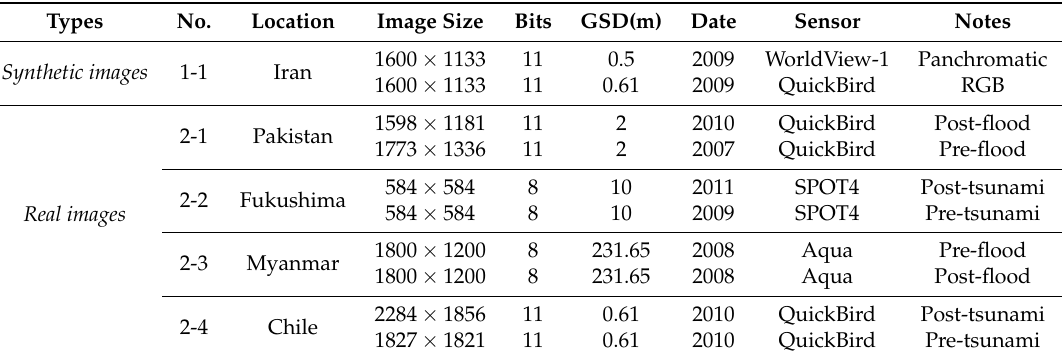
Table 2. Characteristics of data